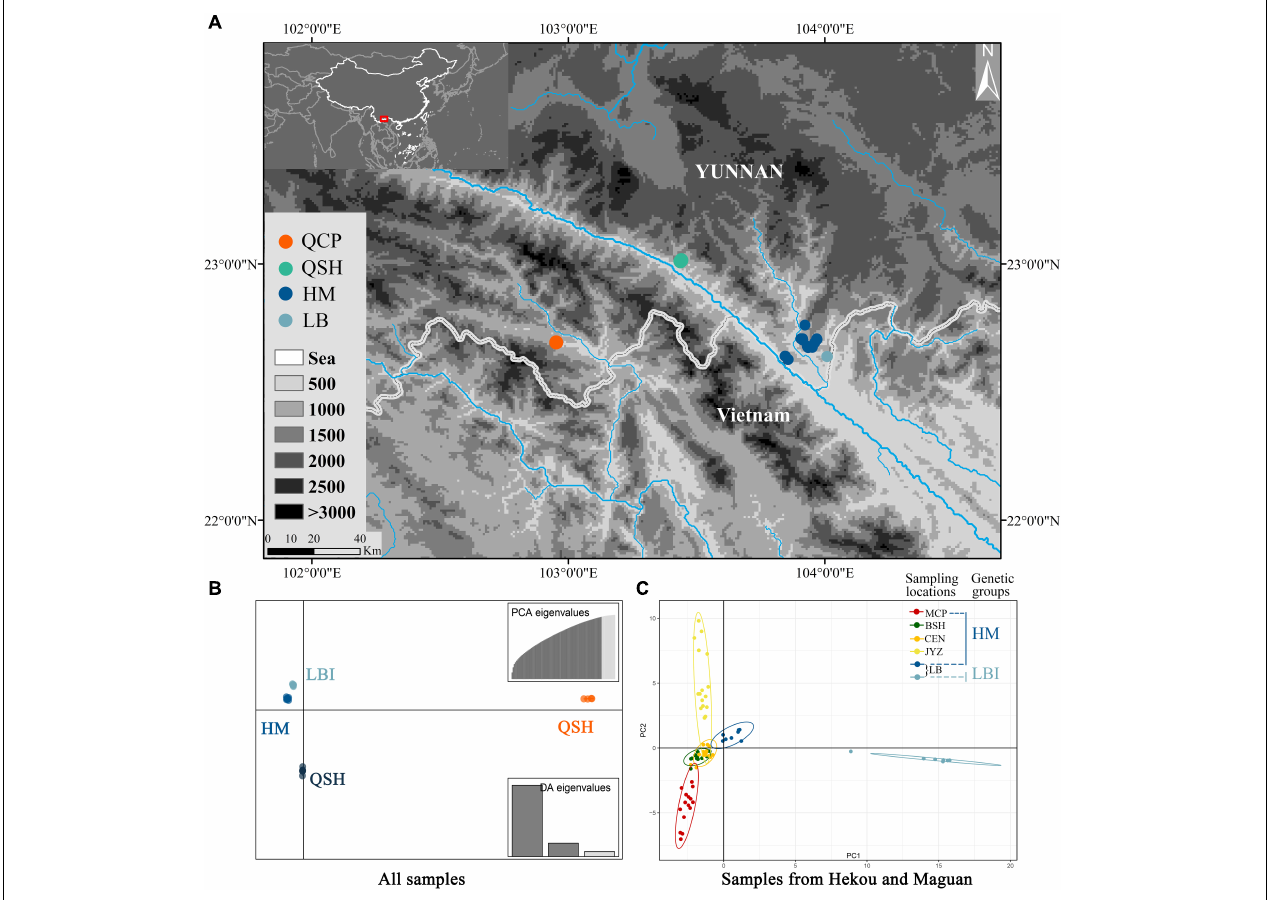
FIGURE 2 | (A) Map of all sampling locations; HM represents the sampling locations of MCP, BSH, CEN and JYZ. (B) DAPC results from the Stacks data set with all populations and (C) PCA results from the Stacks data set with samples from Hekou and Maguan: HM and LBI are two genetic groups divided by DAPC analysis using samples from Hekou and